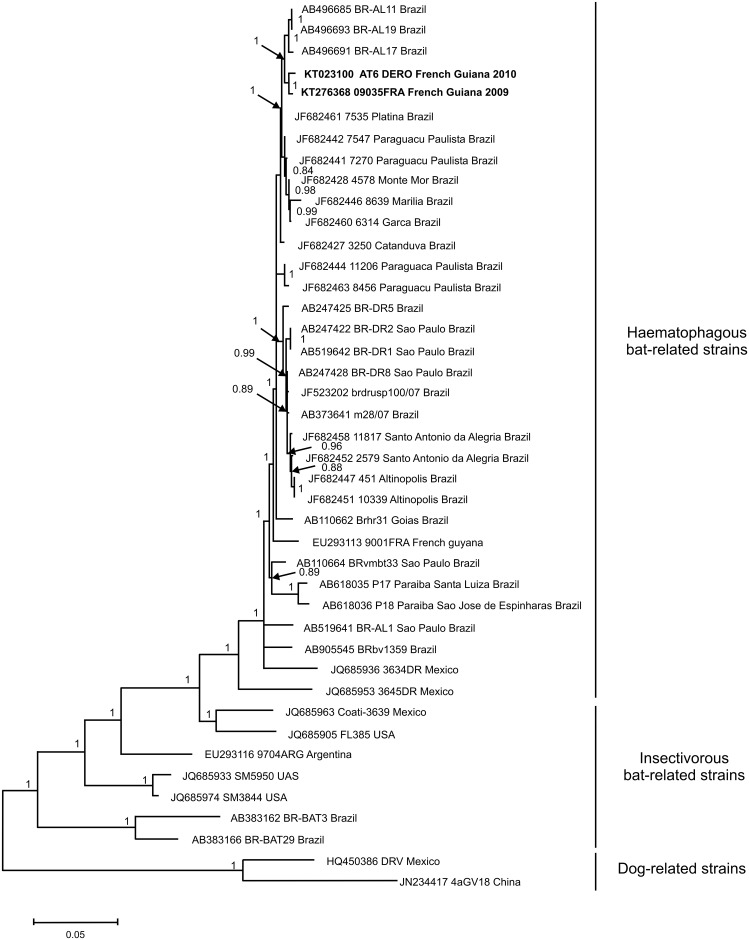
Phylogenetic tree constructed using Bayesian methods based on 1572 nucleotides of the complete glycoprotein gene.Virus names are associated with their accession numbers. Novel sequences generated from the two rabid bats in this study are shown in bold. Support for nodes is provided by the posterior probabilities of the corresponding clades. All resolved nodes have a posterior probability greater than 0.8. Scale bar indicates nucleotide sequence divergence among sequences.